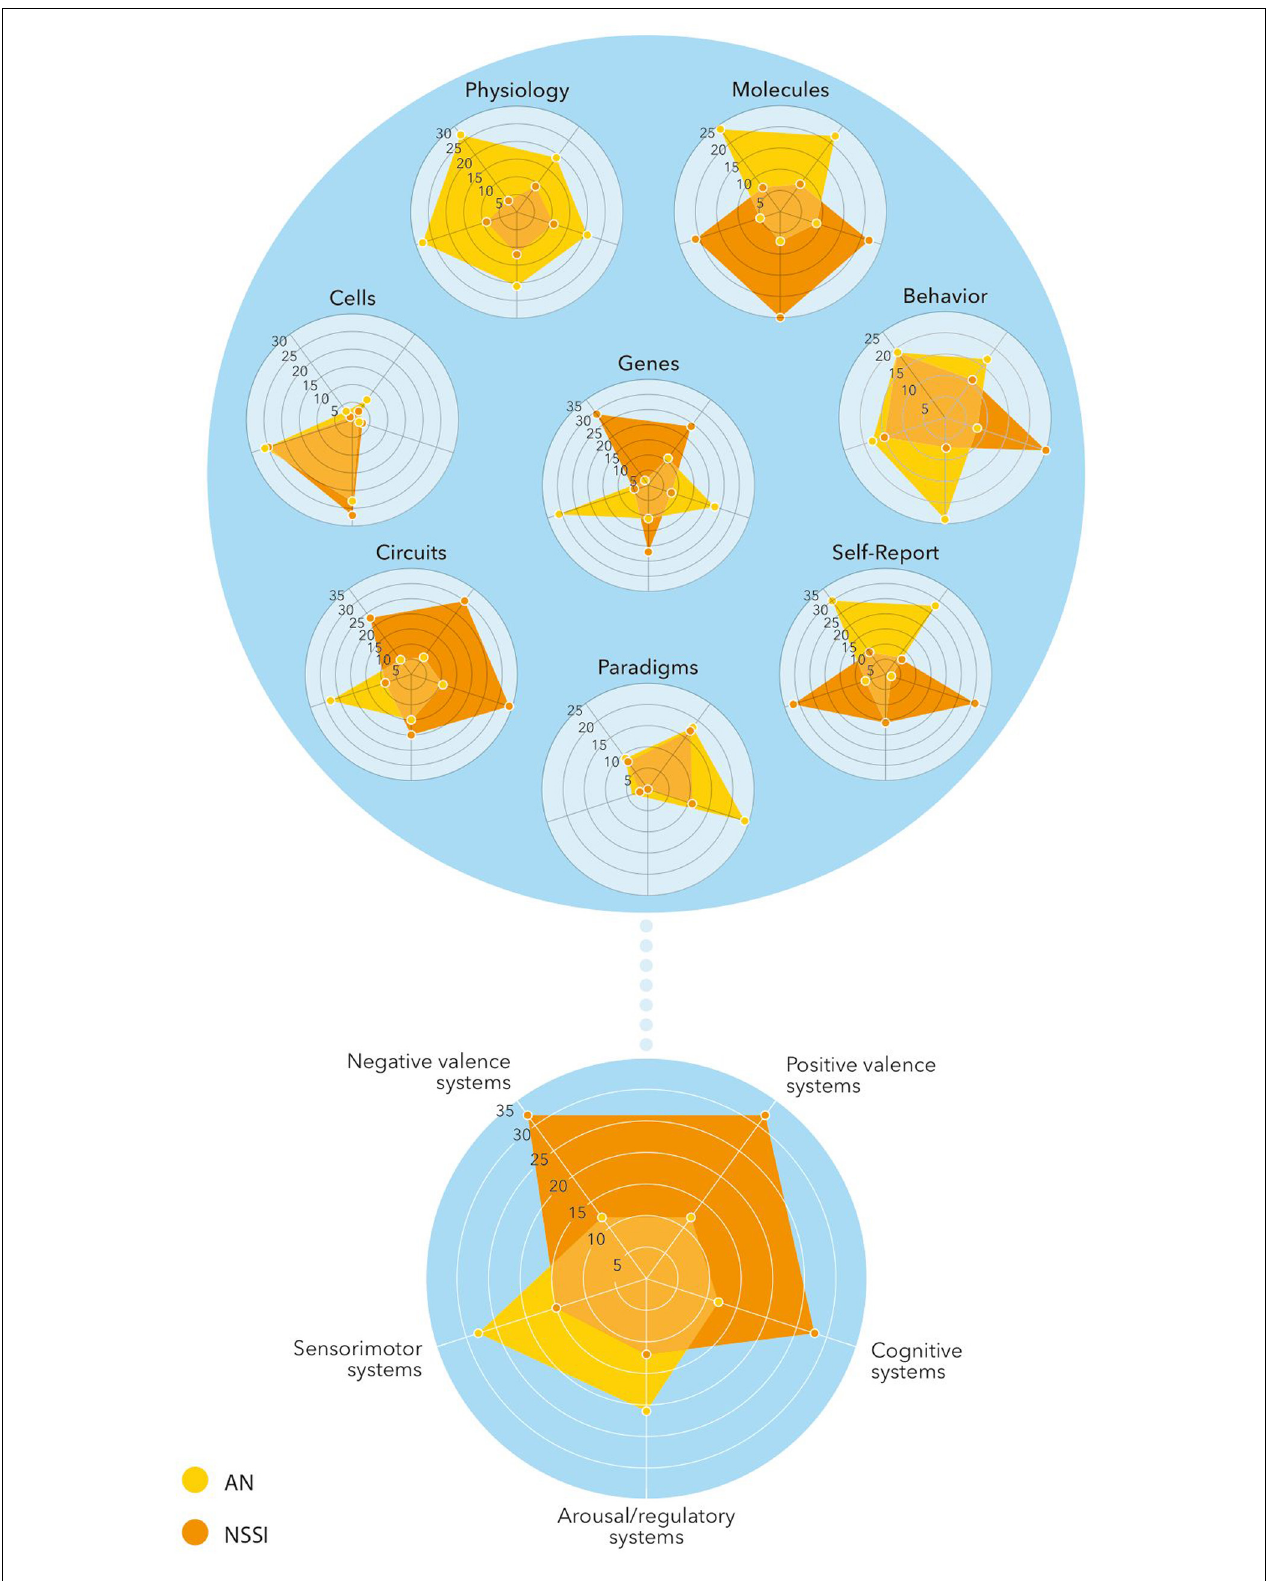
FIGURE 3 | Conceptualization of the relationship between AN and NSSI via the RDoC framework.